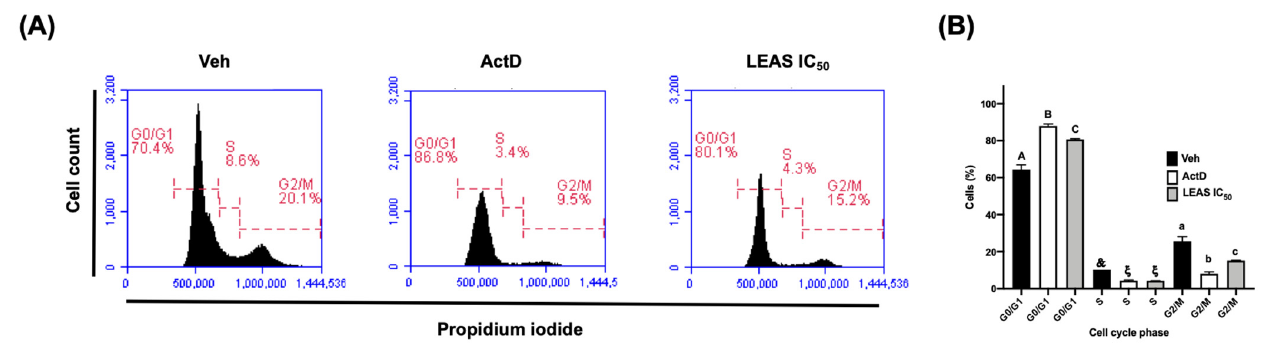
Figure 7 . Effect of LEAS on cell cycle progression . ( A ) The cell cycle phases were determined by flow cytometry using propidium iodide. Cells were treated for 48 h with LEAS IC 50 (15.5 µg/mL), vehicle (DMSO 0.1%), or ActD (actinomycin D, 80 µg/mL). ( B ) The graphic shows the percentage of cells in the different cell cycle phases. Each bar shows the mean of triplicates ± SE. For each sample, 20,000-gated events were acquired. Statistically significant differences of each phase of the cell cycle between the treatments are indicated ( p < 0.05). ActD = Actinomycin D (80 µg/mL). Veh = vehicle (DMSO 0.1%).